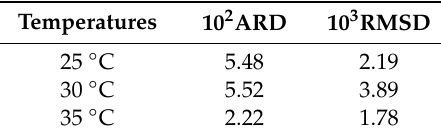
Table 2. Average relative deviation (ARD) and root-mean-square deviation (RMSD) of the simulated